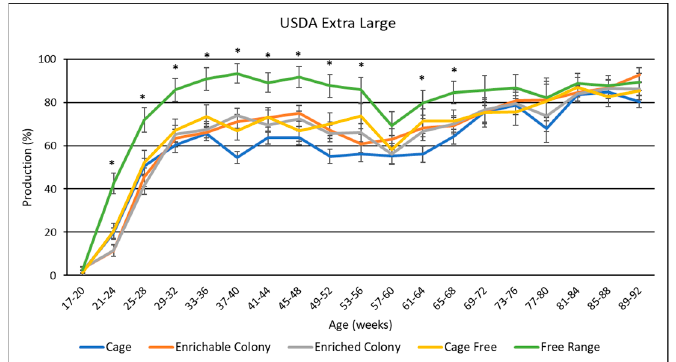
Figure 9. The effect of housing system on USDA extra large production of brown egg layers by age. * Signifies a significant effect ( p < 0.05) of housing environment during the age range on USDA extra – large percentage.